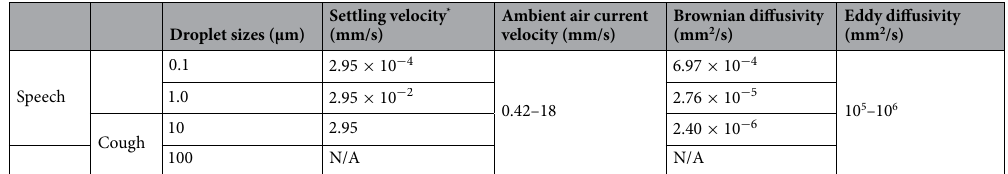
Table 2. Comparison of competing dispersion effects in the post-puff phase. *Settling velocity calculated assuming Stokes’